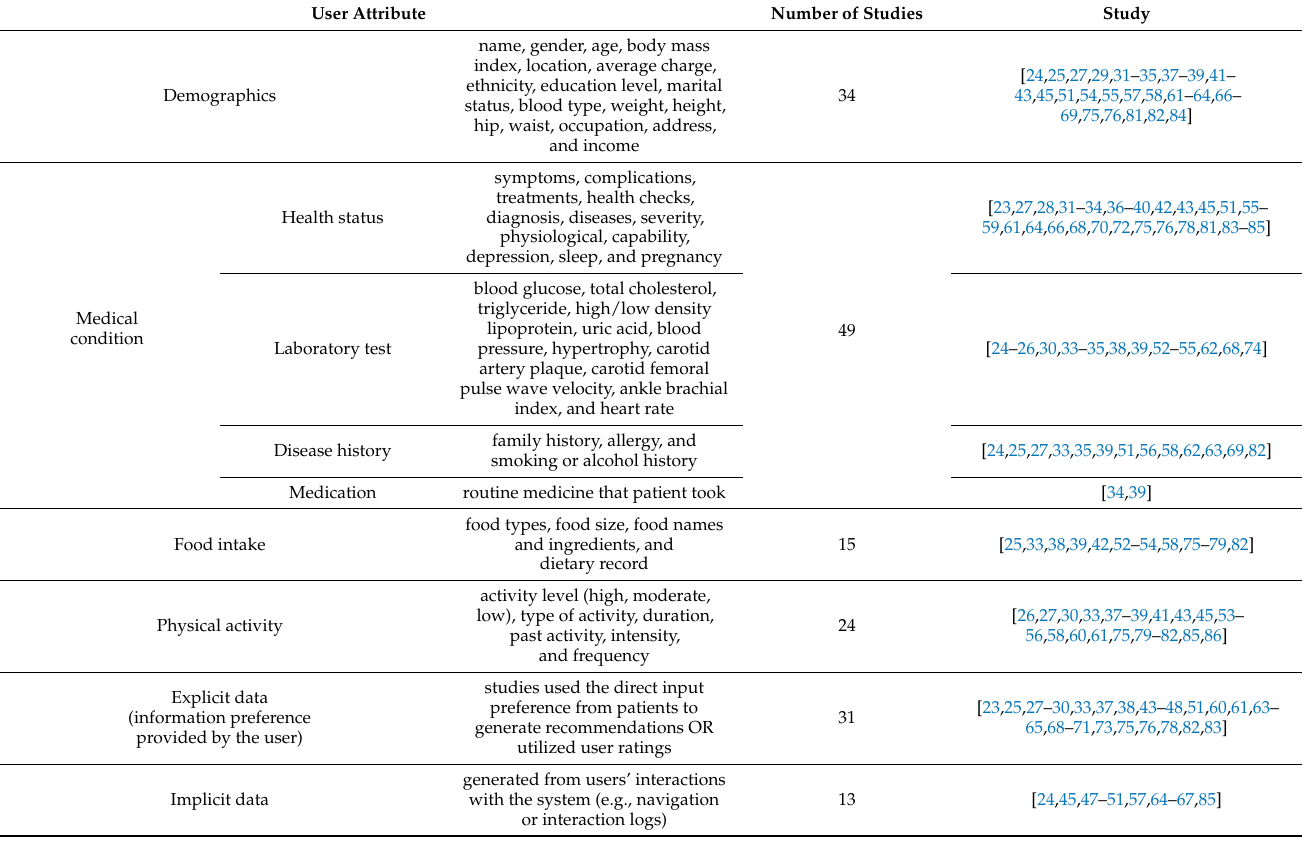
Table 3. Attributes of user model.